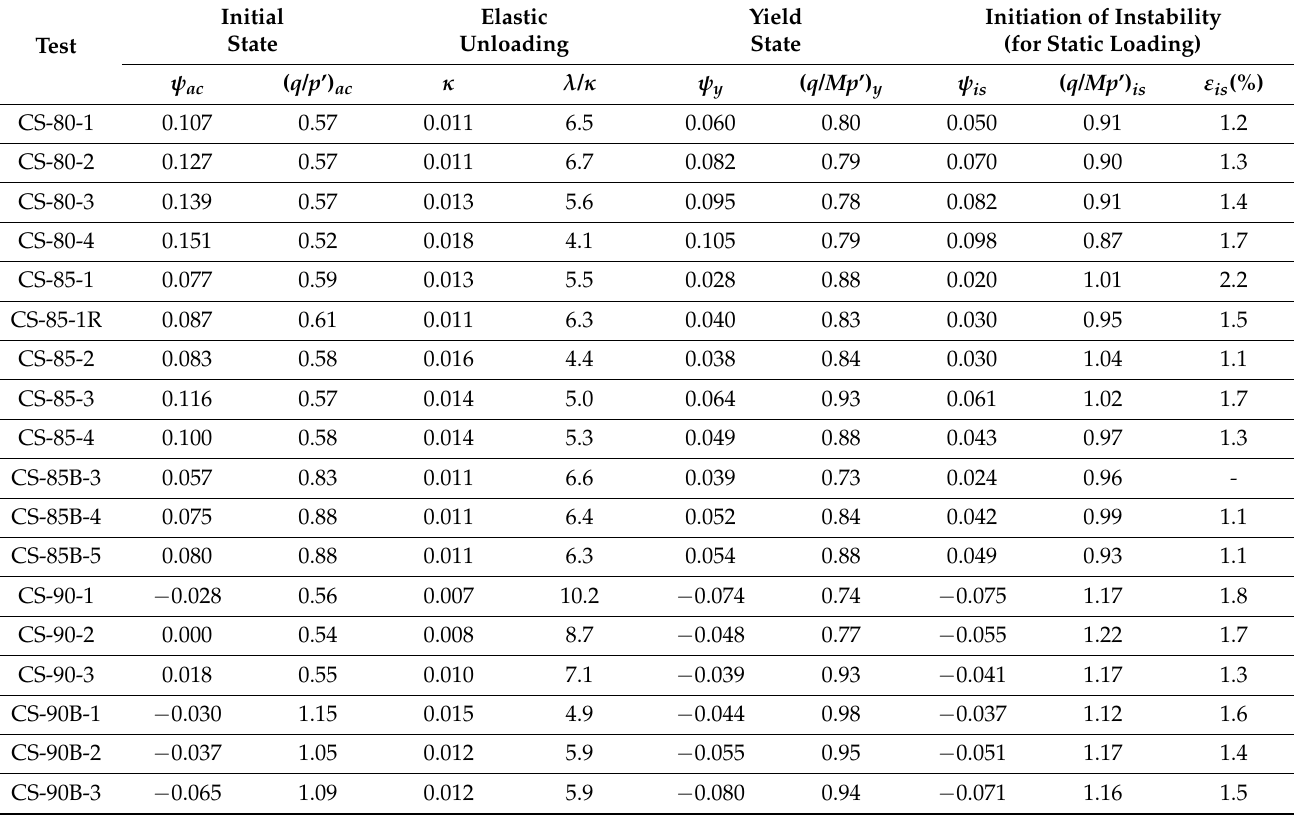
Table 5. Summary of constant shear (CS) stress test